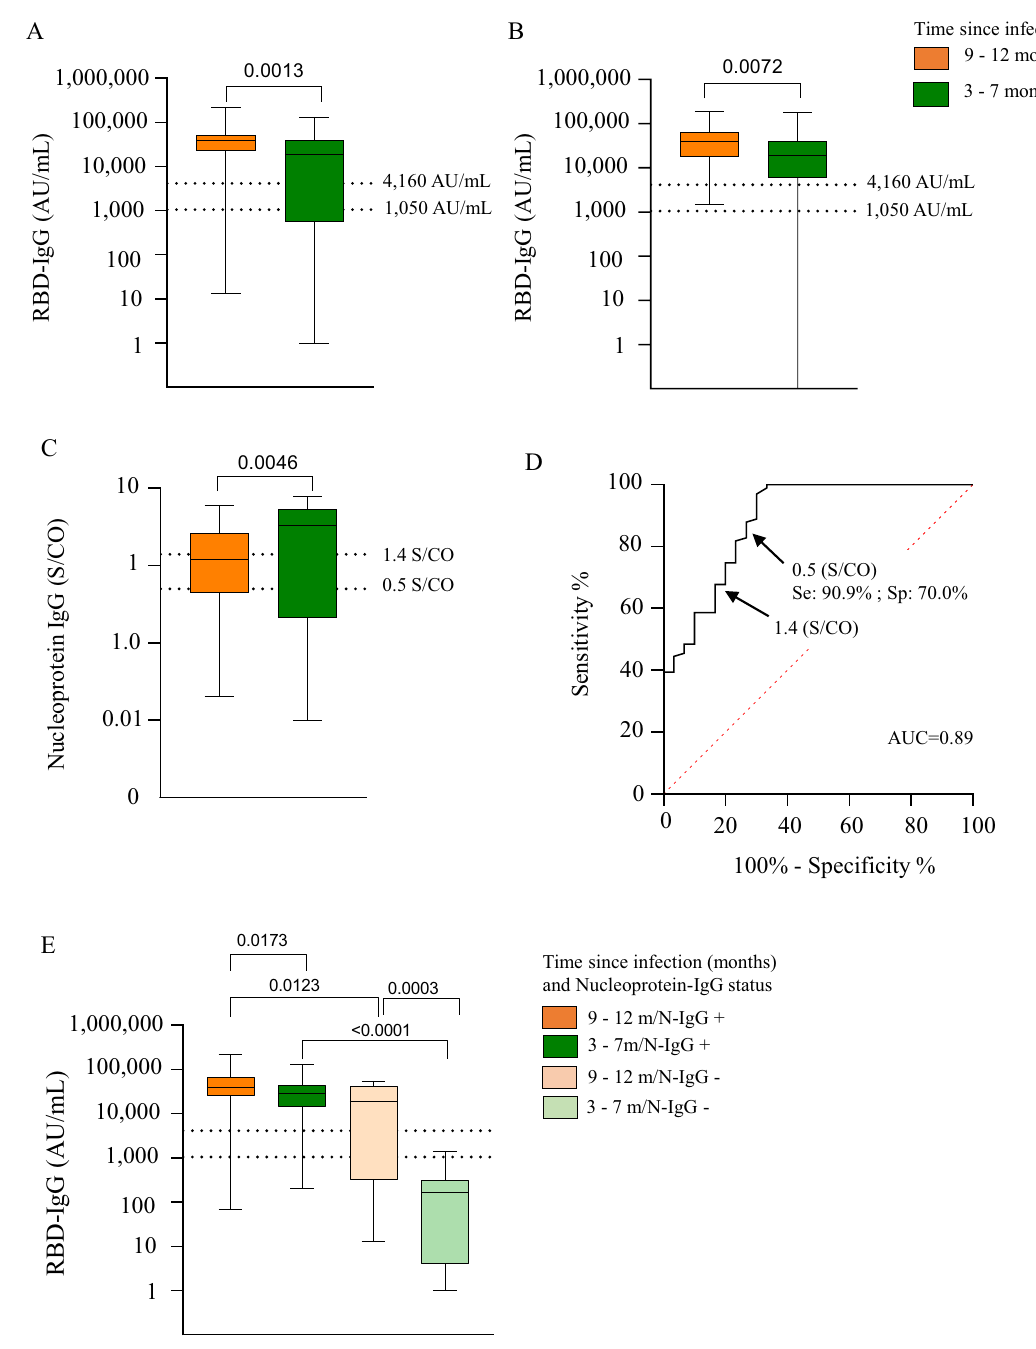
Figure 3. Impact of the interval between infection and vaccination and nucleoprotein-IgG status on RBD- IgG levels after the first dose. ( A ) RBD-IgG level according to the interval between SARS-CoV-2 infection and first dose. ( B ) RBD-IgG level according to the interval between SARS-CoV-2 infection and second dose. ( C ) Nucleoprotein-IgG S/CO value according to interval since SARS-CoV-2 infection. ( D ) ROC evaluating the performance of RBD-IgG S/CO index to predict a high RBD-IgG level after the first dose; RBD-IgG S/CO index > 0.5: PPV: 90.9%; NPV: 96.3%; sensitivity: 90.9% ; specificity: 70.0%). ( E ) RBD-IgG level after the first dose according to nucleoprotein-IgG status and interval since SARS-CoV-2